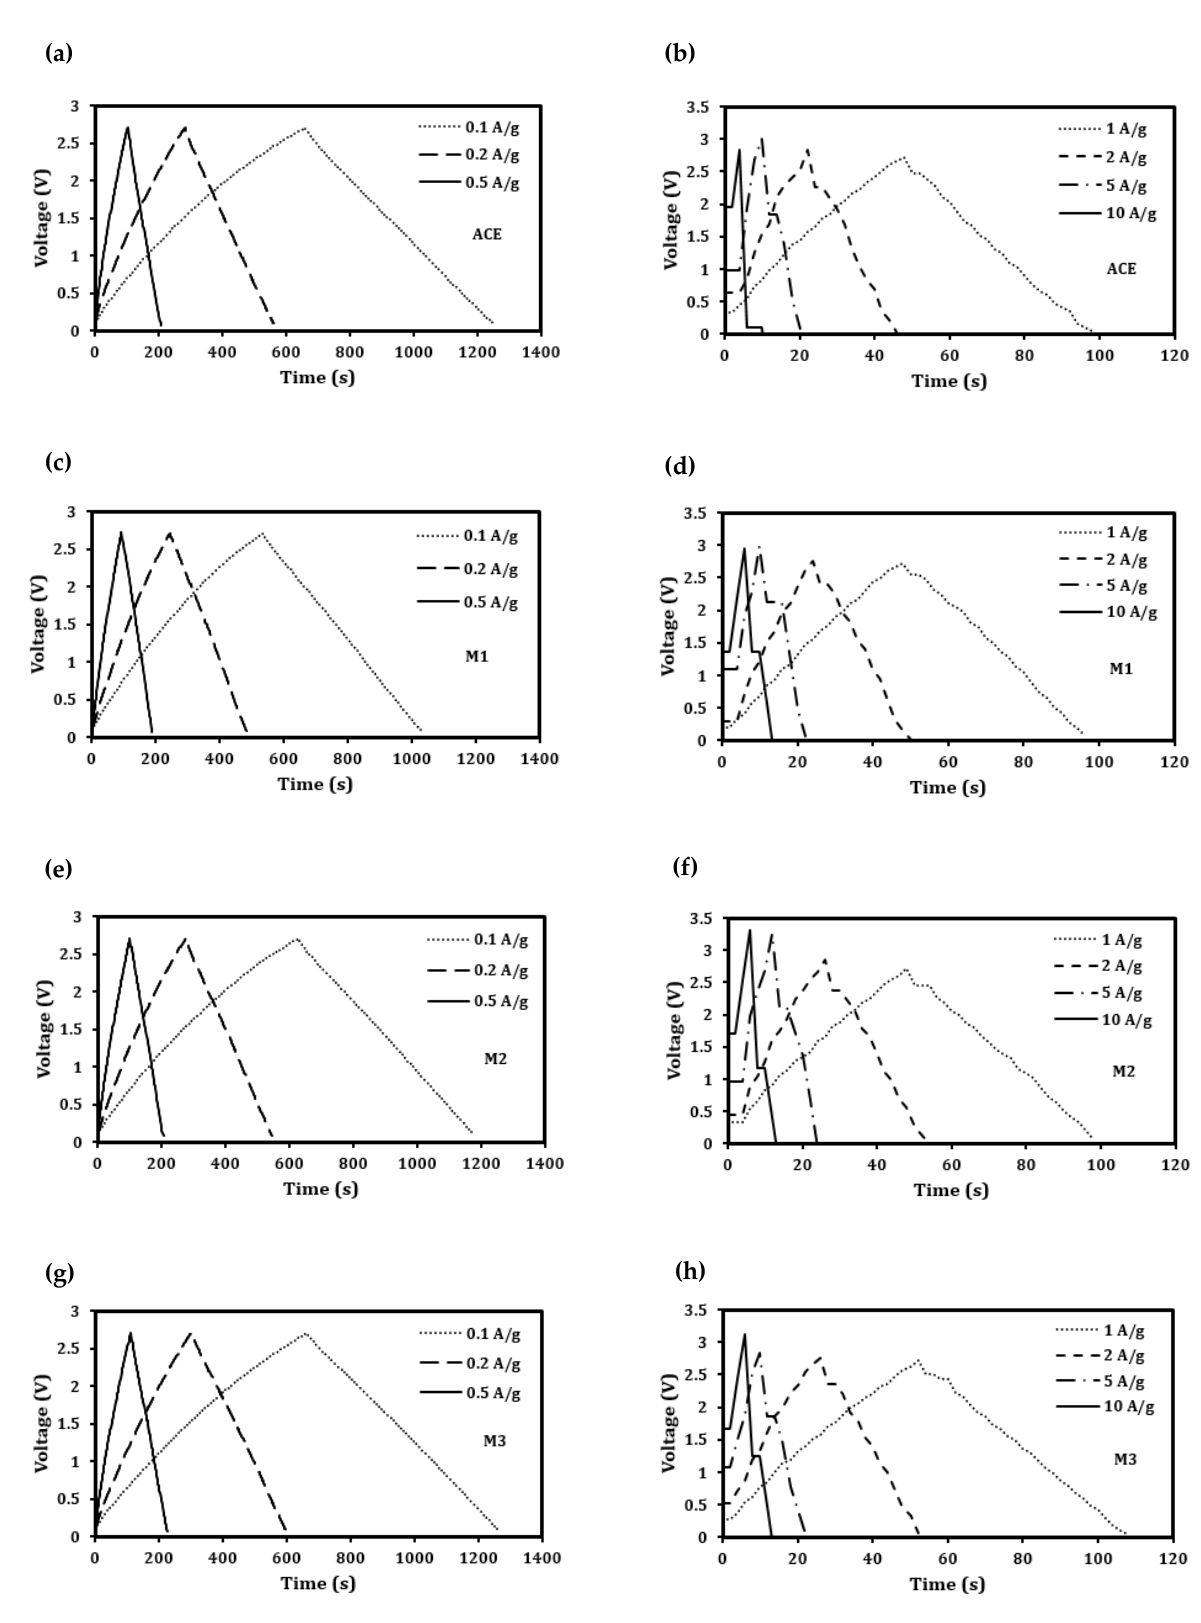
Figure 5. Representative voltage–time curves for rate performance test split between 0.1–0.5 A g − 1 ( a , c , e , g ) and 1–10 A g − 1 ( b , d , f , h ). Subfigures ( a , b ) correspond to ACE, ( c , d ) correspond to M1, ( e , f ) correspond to M2, and ( g , h ) correspond to